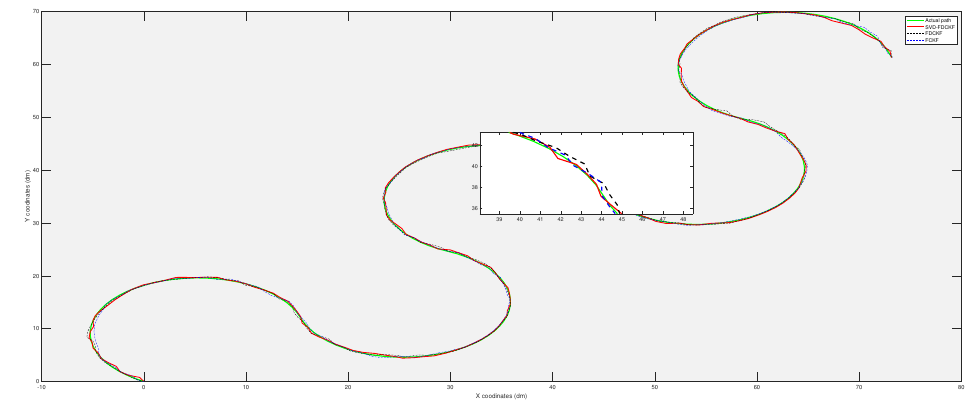
Figure 5. The comparison of the real trajectory of the mobile robot with the SVD-FDCKF estimated trajectory and FCKF estimated